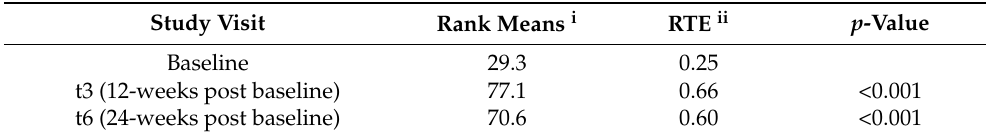
Table 3. Time comparisons for physical exercise participation from the mixed model estimates with imputed data. Study Visit Rank Means i RTE ii p -Value Baseline 29.3 0.25 t3 (12-weeks post baseline) 77.1 0.66 <0.001